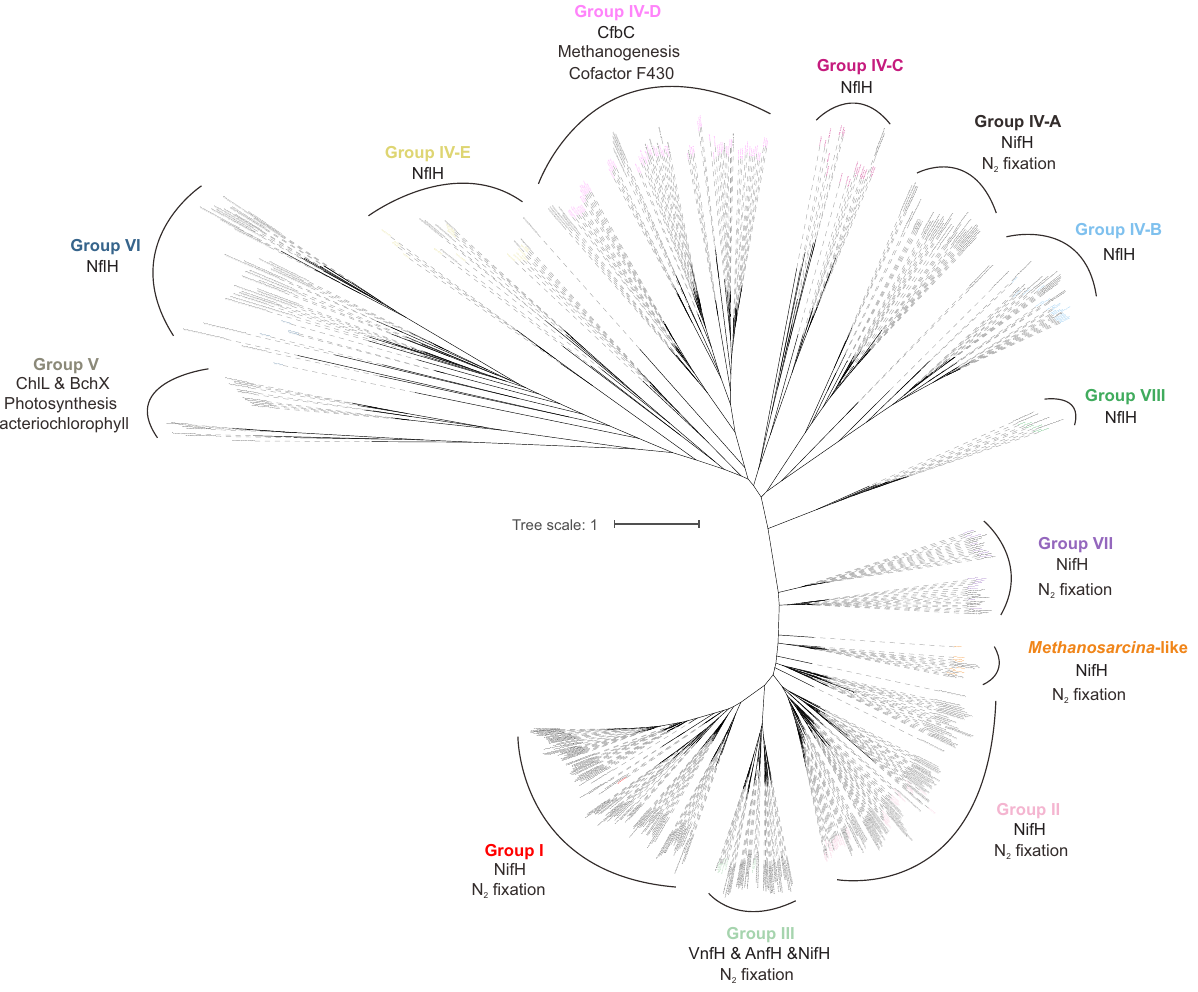
to VI, and newly assigned groups including groups of Methanosarcina -like, VII and VIII. N fl H denotes NifH-like sequences. Scale bar indicates the mean number of substitutions per